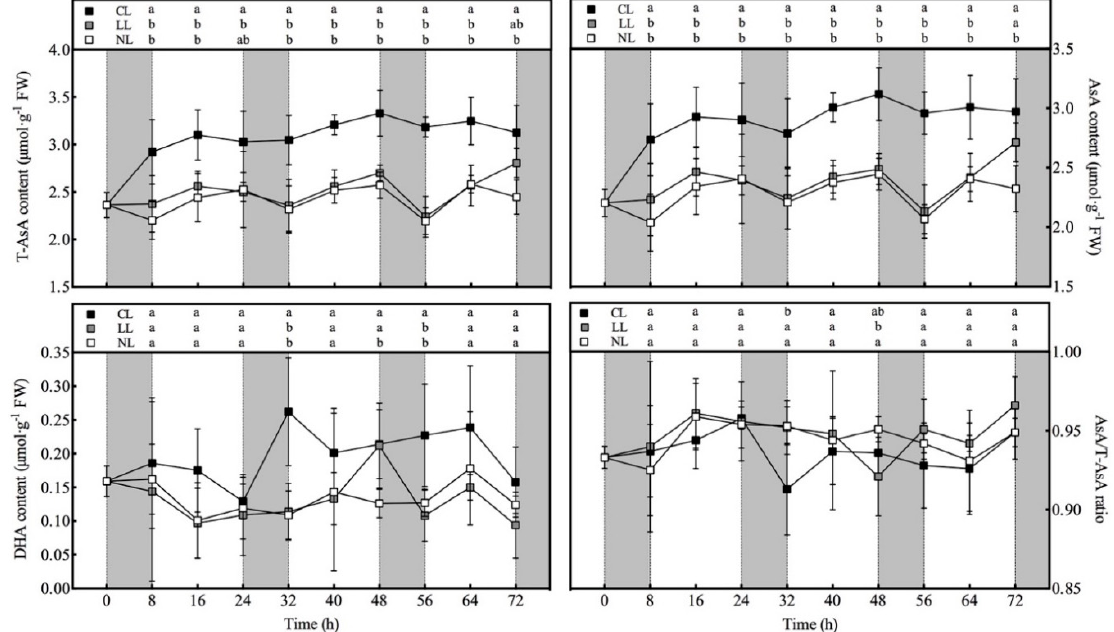
Figure 1. Effects of light intensities at night time on AsA, DHA, and T-AsA contents as well as the ratio of AsA/T-AsA in lettuce leaves under red and blue continuous light. Note: The error line in the figure is the standard deviation. Different letters in the same column indicate significant differences at the p < 0.05 level according to Tukey test. (the same below).